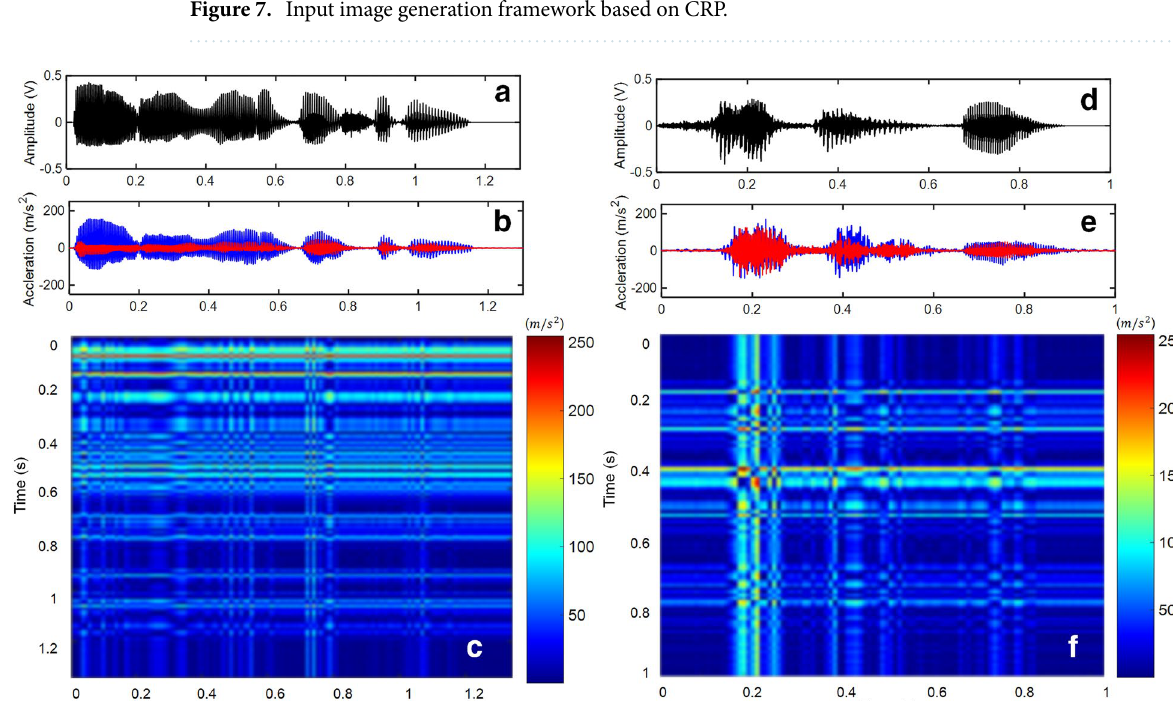
Figure 8. Cross-recurrence plot for speech signals. ( a ) speech signal of sound (Inha university), ( b ) its two acceleration signals, ( c ) corresponding CRP (pixel size: 134 × 134 ), ( d ) speech signal of the sound (happy house), ( e ) its two acceleration signals, ( f ) corresponding CRP (pixel size 134 × 134